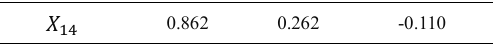
Table 7. Composition equation of principal components of user